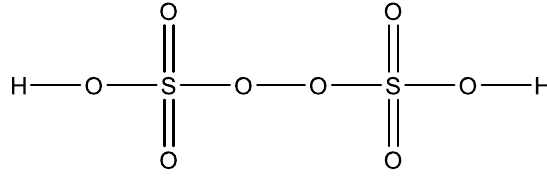
Figure 1. PS structural formula.